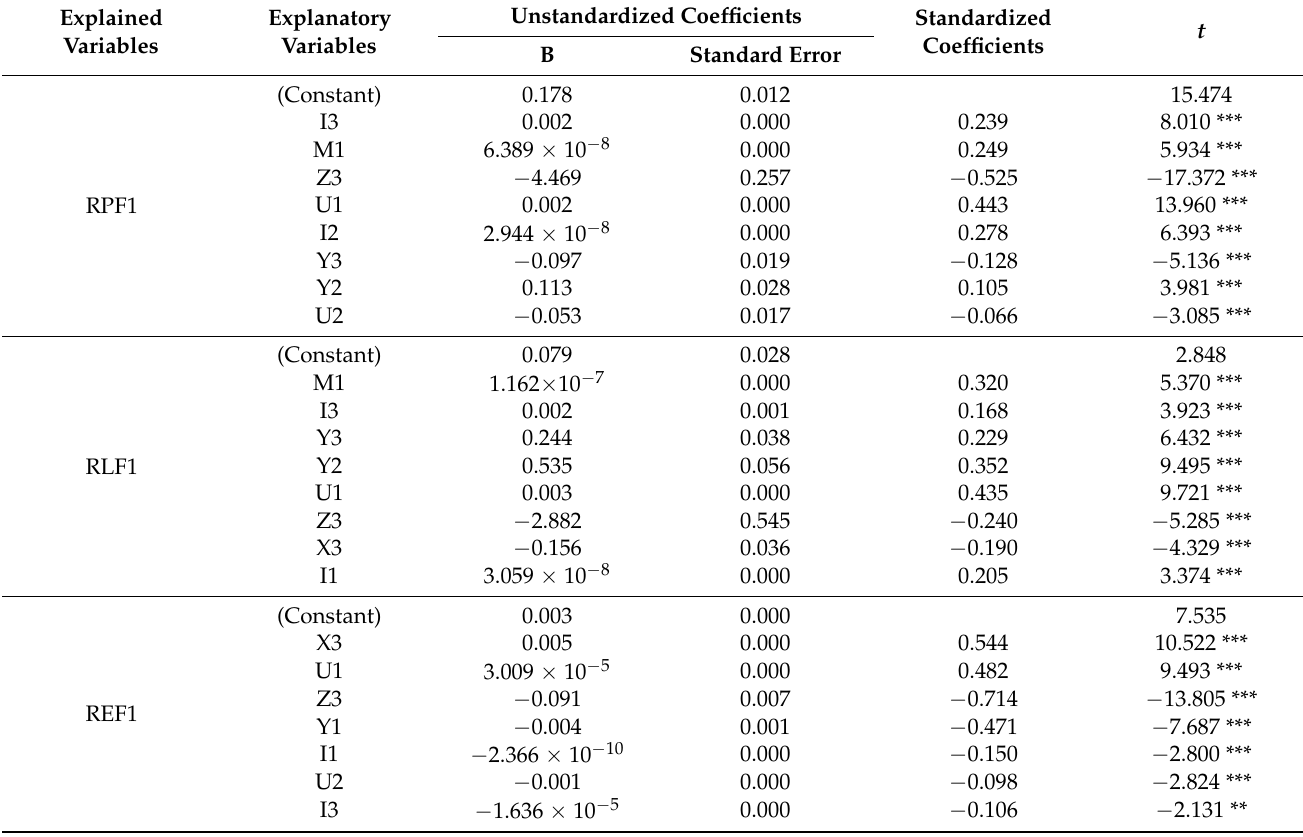
Table 4. Pathways of the territorial changes of rural areas of Jianghan Plain.